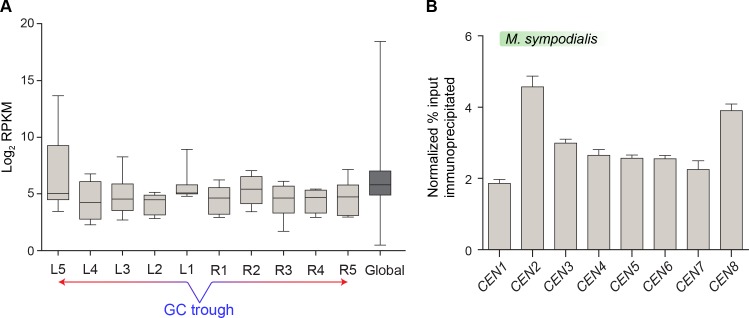
Mtw1-enriched regions in M. sympodialis contain transcriptionally active genes.(A) Normalized read counts (RPKM) for transcripts from ORFs flanking the centromere as compared with the genome average RPKM value calculated from RNA-seq data of M. sympodialis (ATCC42132). The x-axis represents ORFs labeled L1–L5 and R1–R5, with L1 and R1 being proximal to the GC trough of the centromere. The genome average considered for comparison is labeled as global. The y-axis represents Log2 RPKM values. (B) ChIP-qPCR assays validating the enrichment of Mtw1 at the centromeres identified by ChIP-sequencing analysis. The x-axis indicates individual CEN regions assayed with primers mapping to the chromosomal GC troughs (see Supplementary file 1 for primer sequences) and the y-axis indicates enrichment of Mtw1 over a centromere-unlinked control region as ‘normalized % input immunoprecipitated’. Values from three experiments, each performed with three technical replicates, were used to generate the plot. Error bars indicate standard deviations (SD).Figure 3—figure supplement 1—source data 1.Source raw data for Figure 3—figure supplement 1B (ChIP-qPCR for GFP-Mtw1 across all M. sympodialis centromeres).